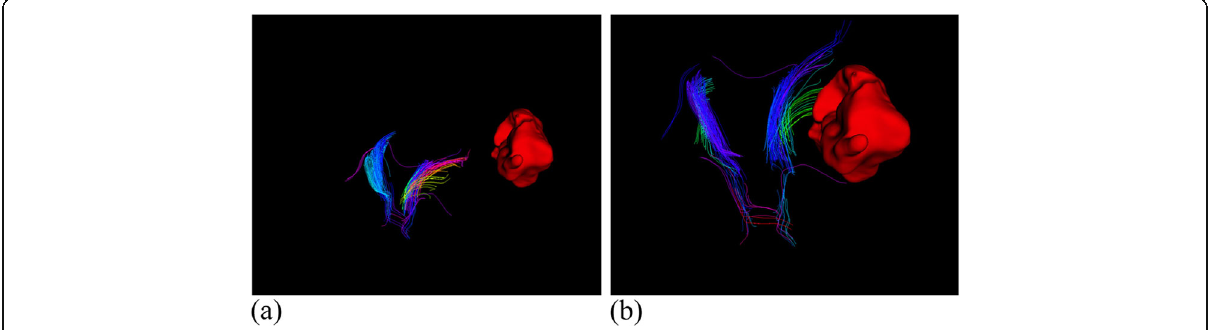
Fig. 1 3D model of before and after registration. ( a ): 3D model before registration; ( b ): 3D model after